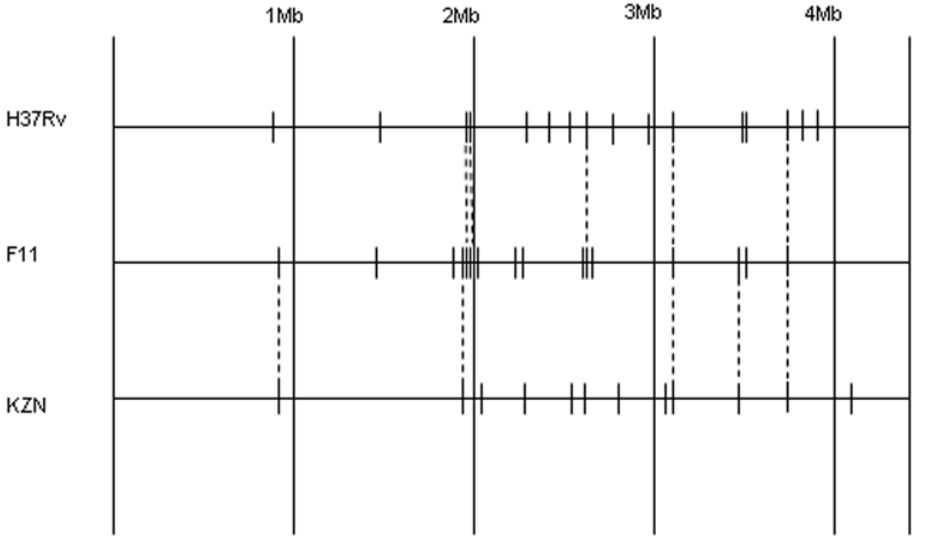
Figure 1. Locations of the IS-6110 insertion sequences in H37Rv, F11, and KZN-V4207. The dashed lines indicate insertion sites that have been preserved between strains. The sites are only drawn approximately to scale.